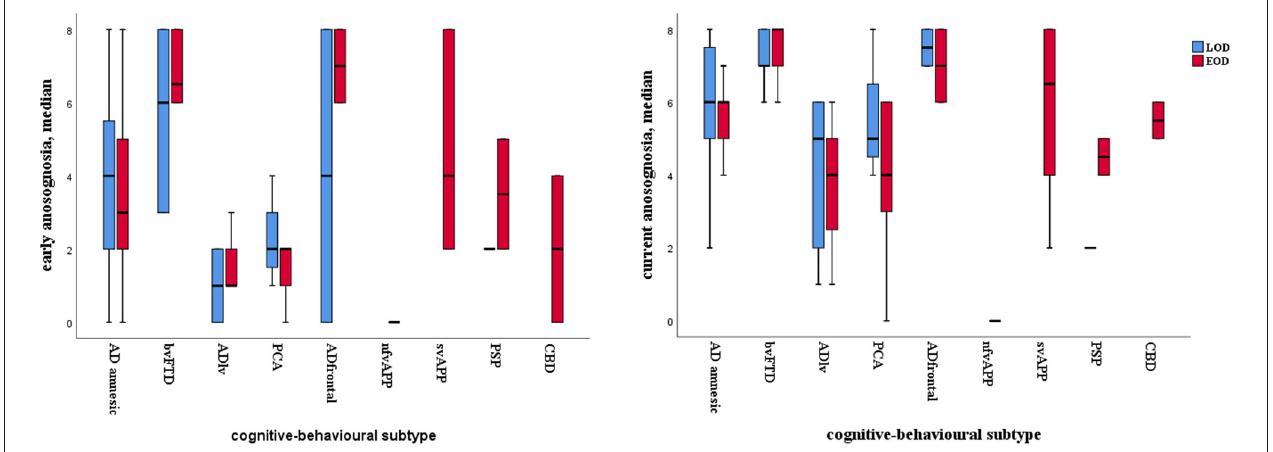
FIGURE 3 | Boxplot of anosognosia level in EOD and LOD for patients classified based on cognitive/behavioral patterns; on the left, early anosognosia; on the right, current anosognosia.